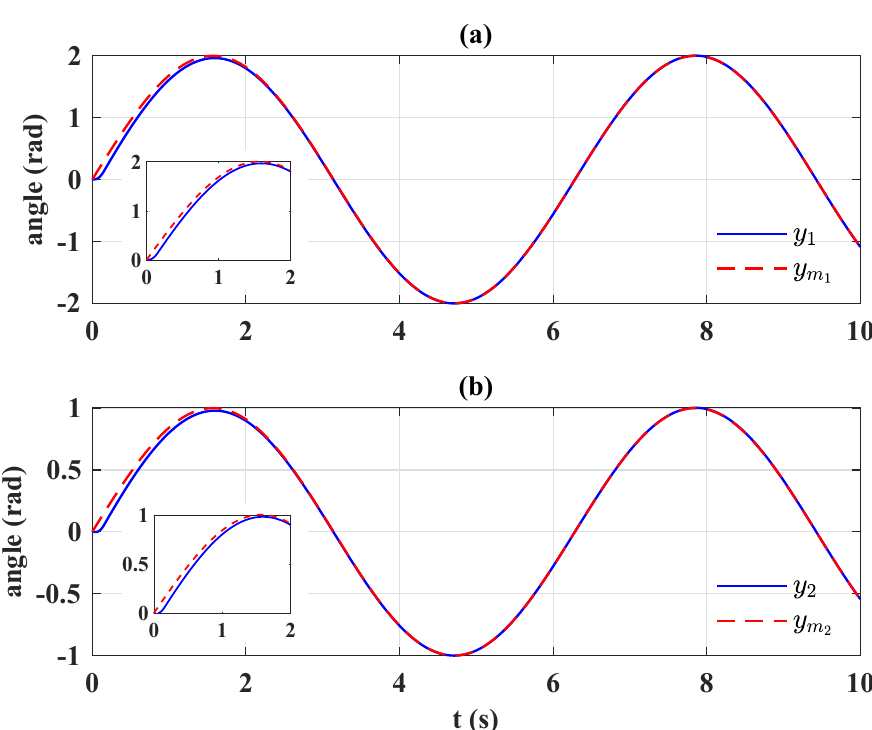
Figure 4. Time history of system outputs and references ( a ) y 1 , y m